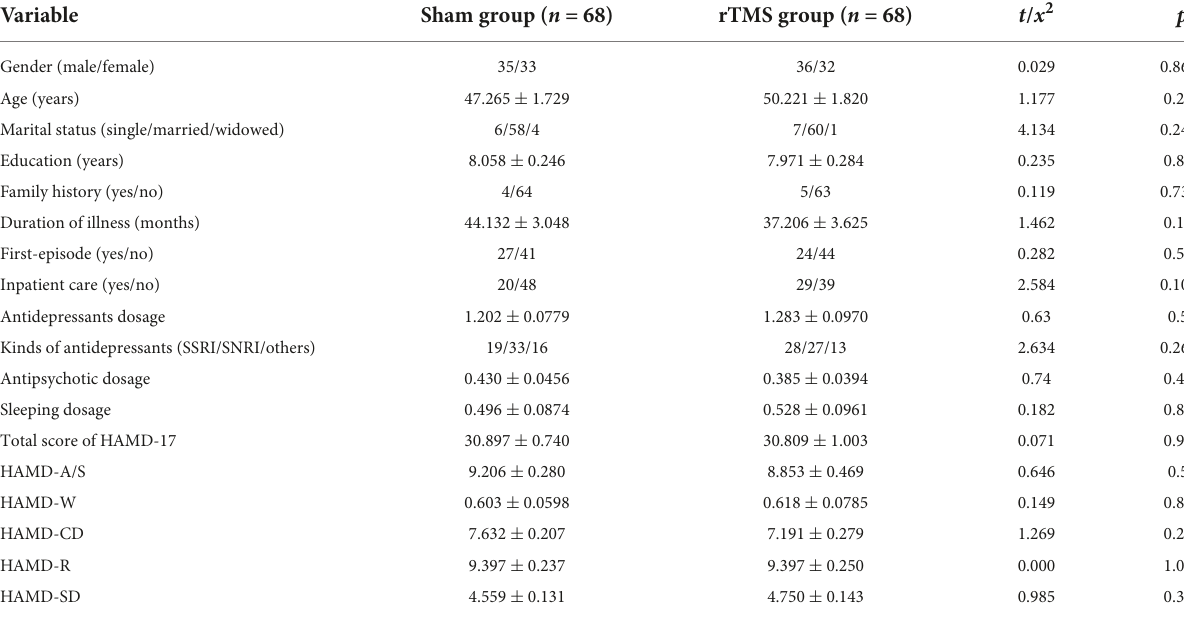
TABLE 1 Demographic and baseline characteristics of sham and repetitive transcranial magnetic stimulation (rTMS) groups.